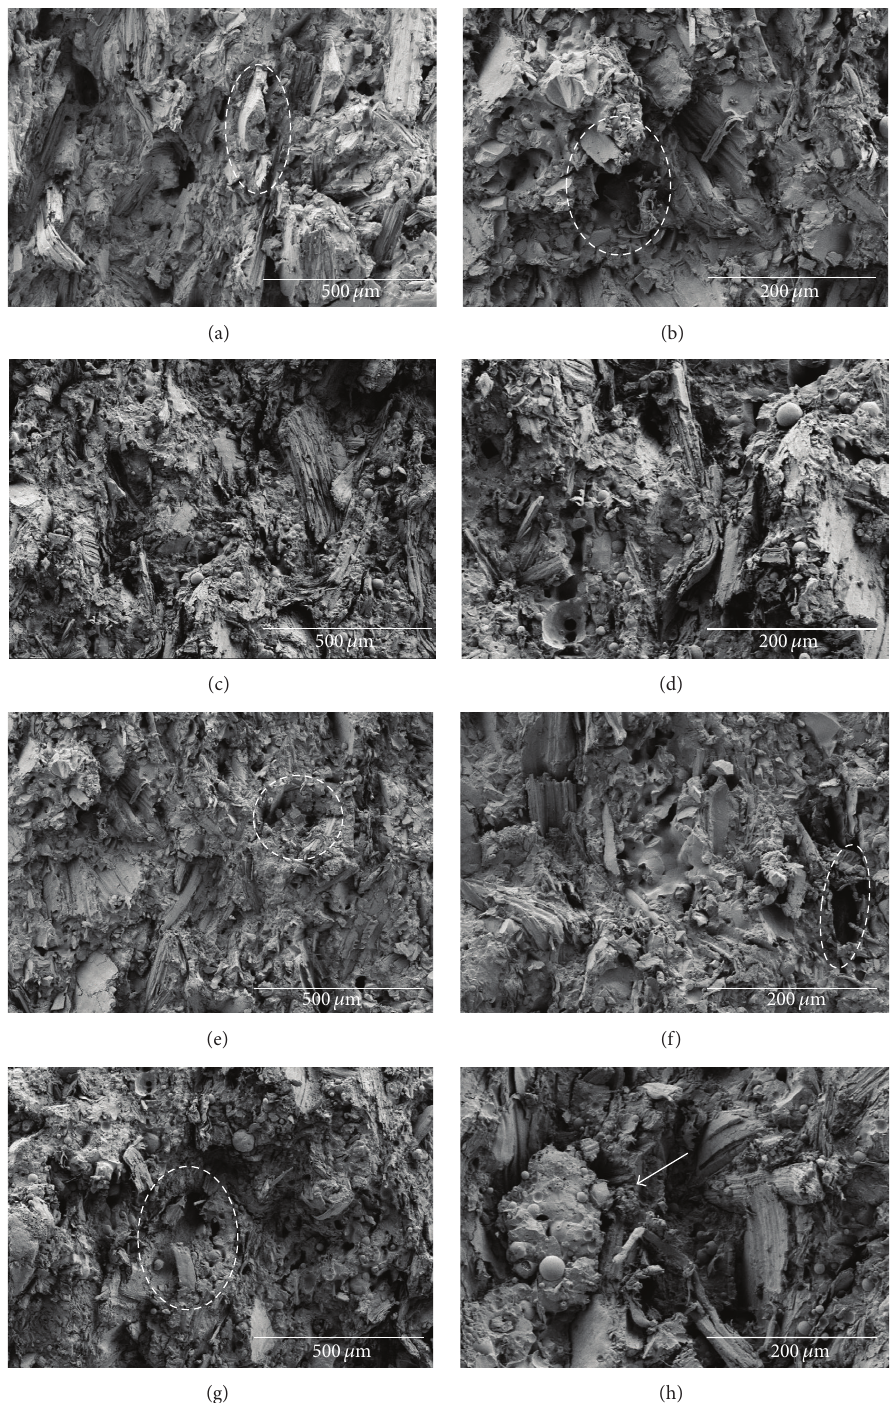
Figure 1: Morphology of fractured surfaces of composites with WS and combined fillers at 50% loading level. First chart, (a) and (b) 50% WS; and other three charts, 25% WS and 25% inorganic filler: (c) and (d) heavy calcium carbonate, (e) and (f) silicon dioxide, and (g) and (h) fly